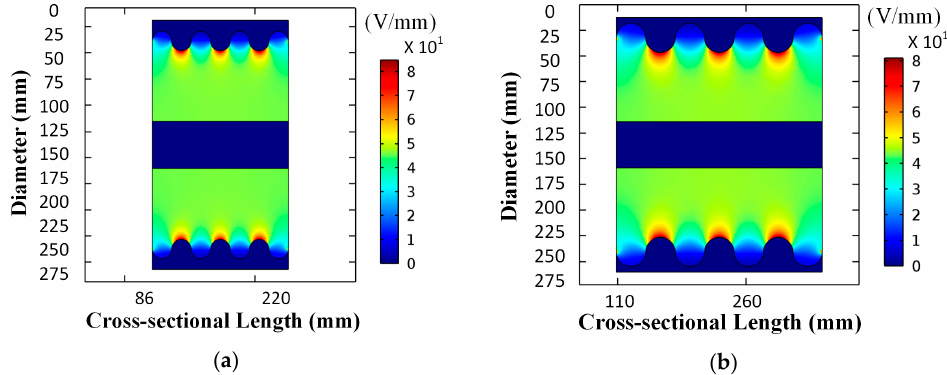
Figure 6. Electric field comparison of corrugated RP GIL: ( a ) Pitch = 38 mm; ( b ) Pitch = 58 mm.